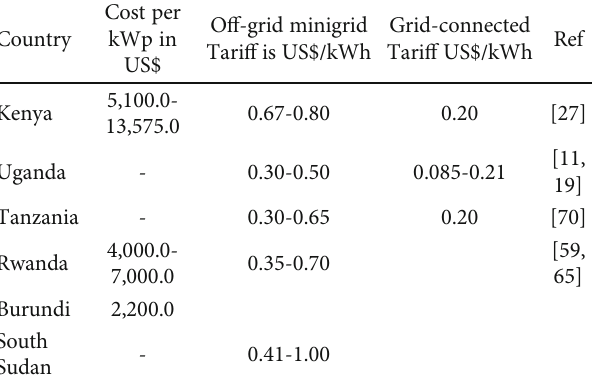
Table 29: Minigrid investment